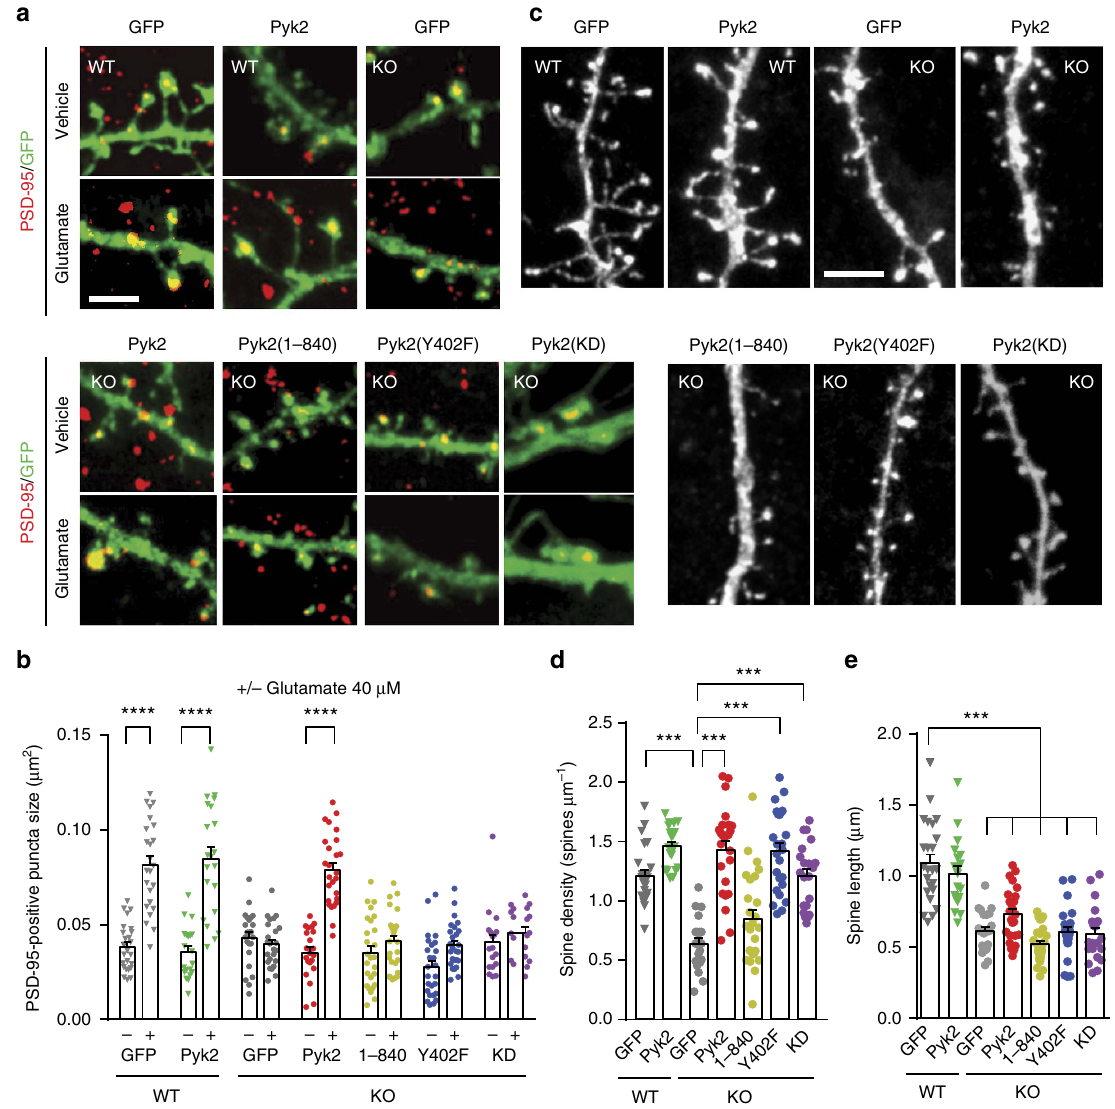
Figure 6 | Autophosphorylation-dependent and -independent roles of Pyk2 in dendritic spines. ( a ) Hippocampal neurons from wild-type (WT) and Pyk2 KO mice were cultured for 21–22 days, transfected with plasmids coding GFP or GFP fused to wild-type Pyk2, to Pyk2(1-840), Pyk2(Y402F) or Pyk2-KD (as indicated), and treated with vehicle or glutamate (Glu, 40 m M, 3h). Neurons were imaged for GFP fluorescence (green) and PSD-95 immunoreactivity (red). ( b ) Quantification of GFP/PSD-95 double-positive puncta size (that is, yellow puncta) as in a . Two-way ANOVA: interaction, F (6,312) ¼ 19.07, P o 10 (cid:2) 4 , glutamate effect, F (1,312) ¼ 134.3, P o 10 (cid:2) 4 , Pyk2 expression effect, F (6,312) ¼ 20.06, P o 10 (cid:2) 4 . ( c ) Spine density and length were studied in similar conditions as in a , in the absence of treatment, using GFP or Pyk2:GFP fluorescence. ( d ) Quantification of spine density. One-way ANOVA: F (6,155) ¼ 24.90, P o 10 (cid:2) 4 . ( e ) Quantification of spine length. One-way ANOVA: F (6,157) ¼ 30.68, P o 10 (cid:2) 4 and. In b , d , e , individual data points and means þ s.e.m. are shown, 15–20 dendrites per condition (one–two dendrites per neuron) from two to three independent experiments. Post hoc multiple comparisons were done with Holm-Sidak’s test ( b , d , e ), *** P o 0.001, **** P o 10 (cid:2) 4 . Scale bars, 3 m m ( a ) and 1 m m ( c